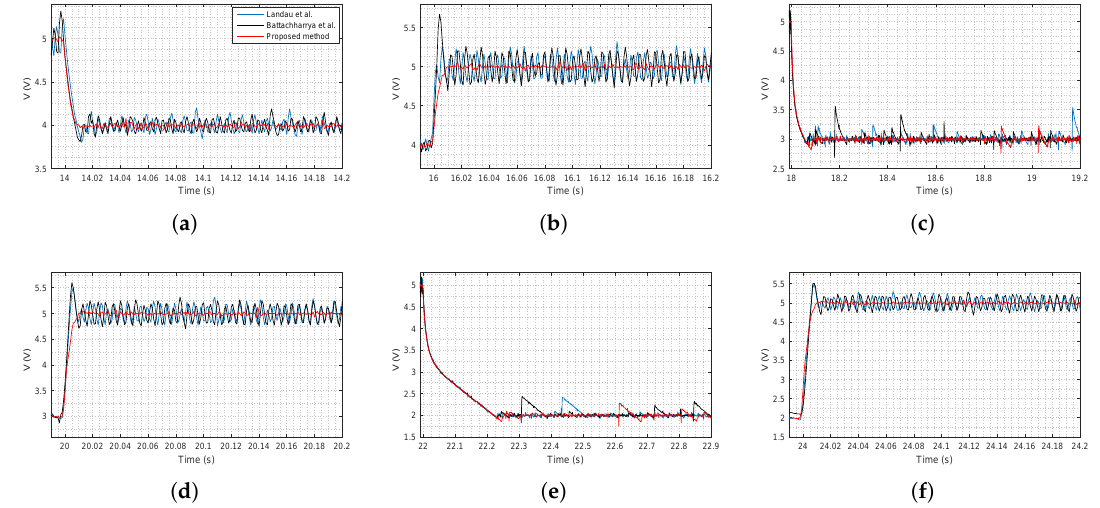
Figure 13. Experimental results of the negative voltage setpoint variation. ( a ) V ref = 4.0 V; ( b ) V ref = 5.0 V; ( c ) V ref = 3.0 V; ( d ) V ref = 5.0 V; ( e ) V ref = 2.0 V; ( f ) V ref = 5.0 V.